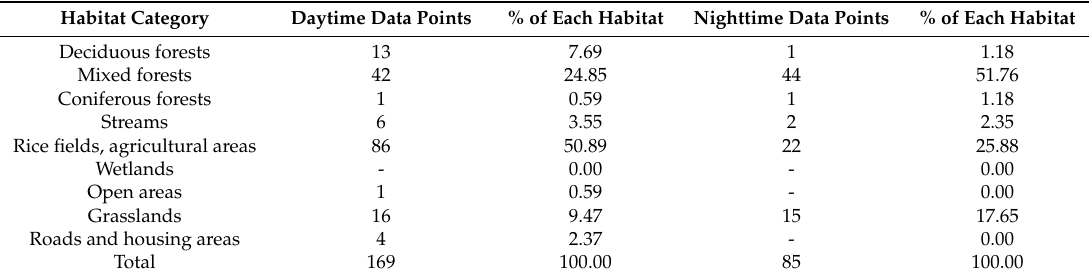
Table 3. The habitat use pattern of red-crowned cranes in Paju areas during daytime (06:00–18:00) and nighttime (18:00–06:00). The habitat use was only obtained during nighttime, and the total area of each habitat was estimated using the kernel method. Color cells for three types of forests Habitat Category Nighttime % Crane Used Size of Each Habitat (%) Deciduous